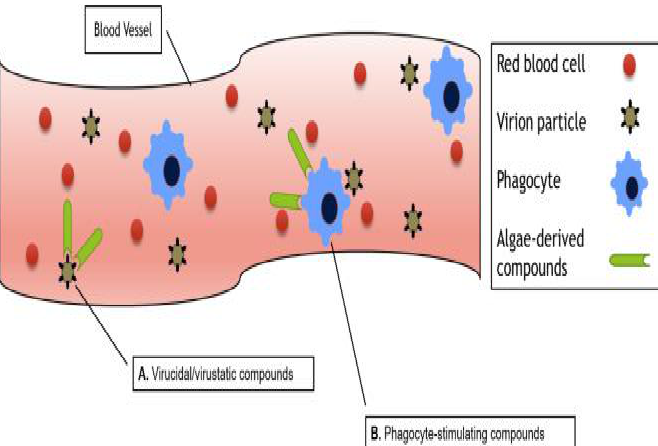
Fig. 7: Diagram illustrate the mechanism of action in which algae have an antiviral effect through block viral attachment A. formation of virucidal or virustatic structure and B. stimulating phagocytic activity ( Daman et al ., 2021 )